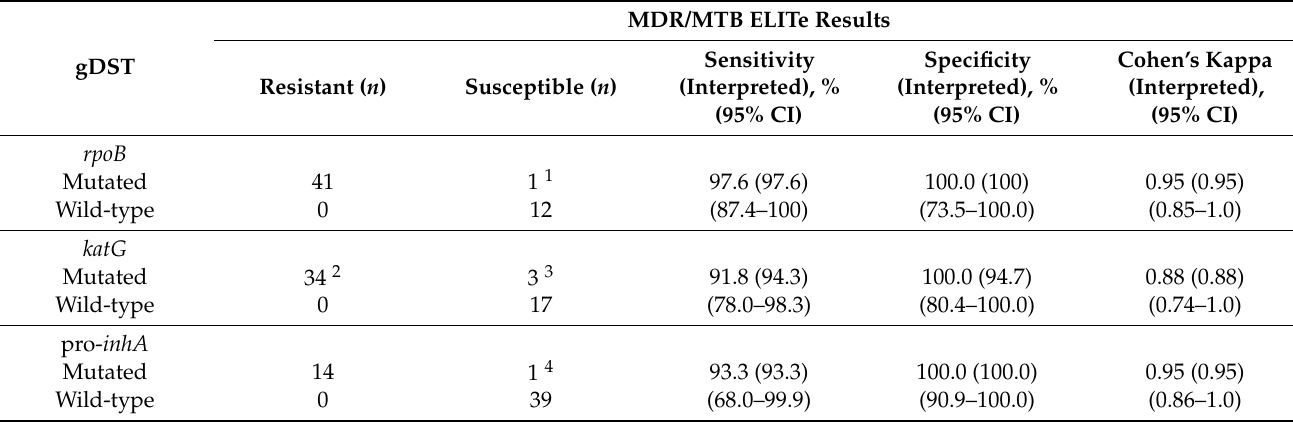
Table 4. Performances of MDR/MTB ELITe MGB ® assay in detecting resistance mutations in rpoB , katG , and pro- inhA on strains ( n = 54) from our NRCMyRMA collection, in comparison with